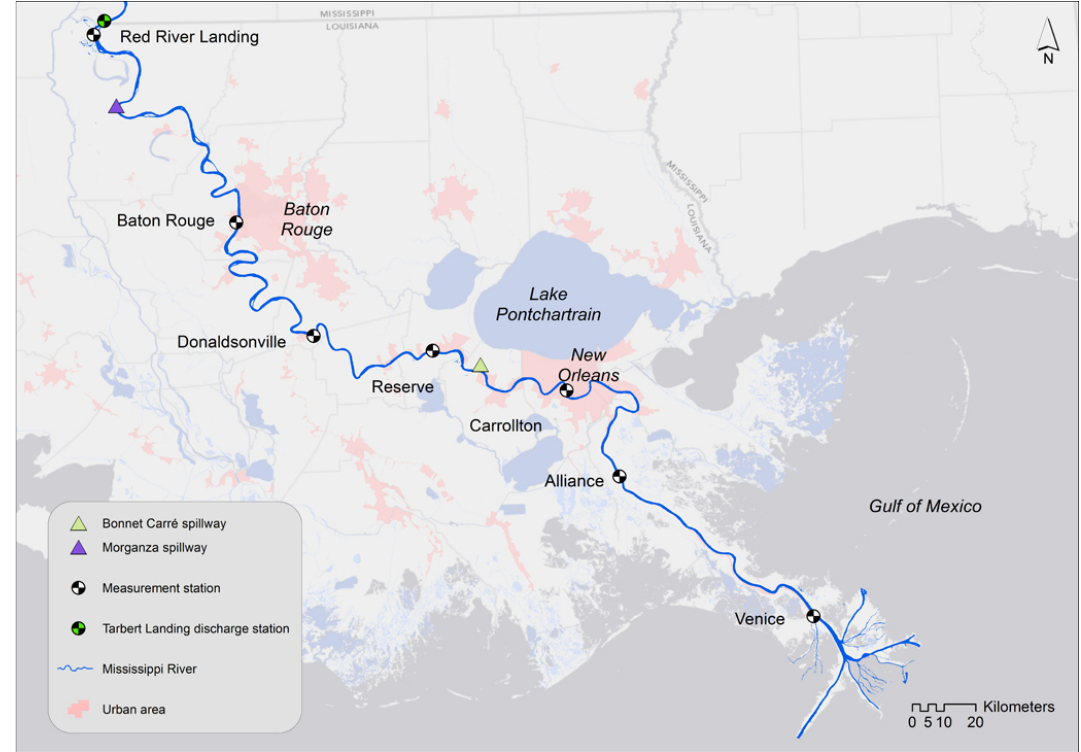
Figure 1. Map of the study area of the Mississippi